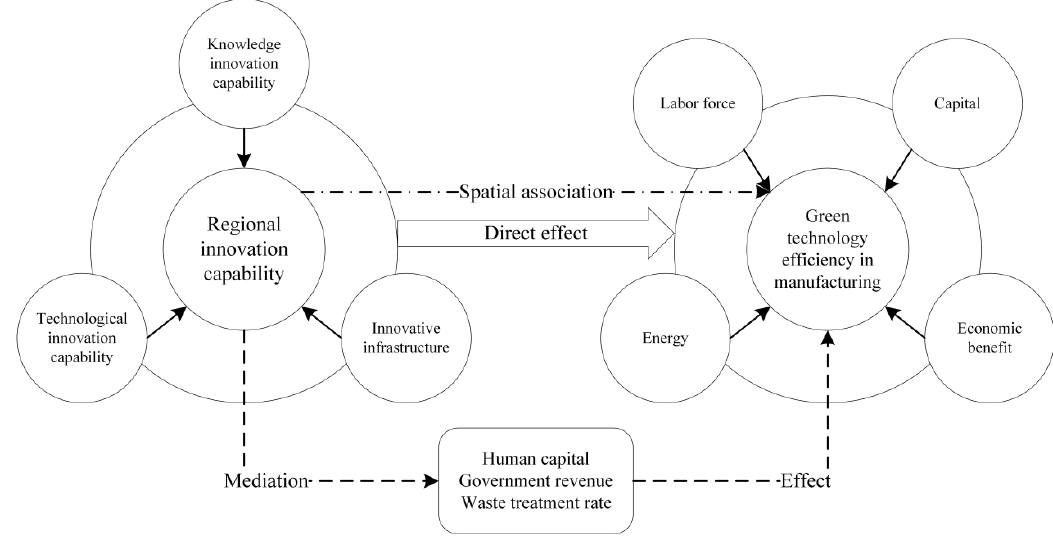
Figure 1. Research framework.